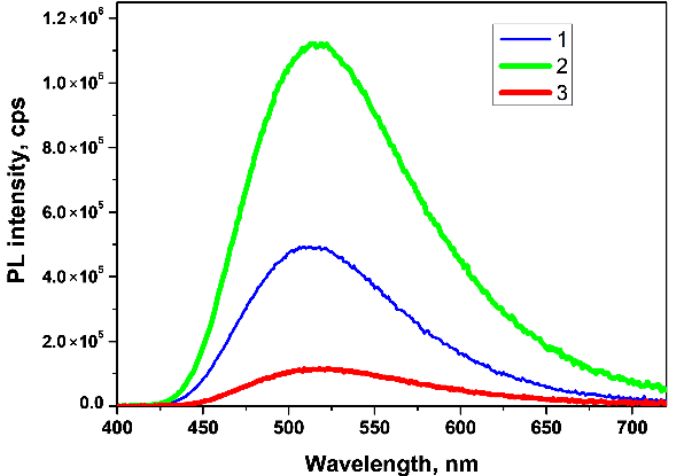
Figure 15. PL spectra of hydrophilic BoronLightSil samples with different concentrations of H 3 BO 3 during gel synthesis: (1) 0.01 wt% for BLS-0.01-HL; (2) 0.05 wt% for BLS-0.05-HL; (3) 0.1 wt% for BLS-0.10-HL ( λ ext = 360 nm). Table 4. Photoluminescent characteristics of BoronLightSil